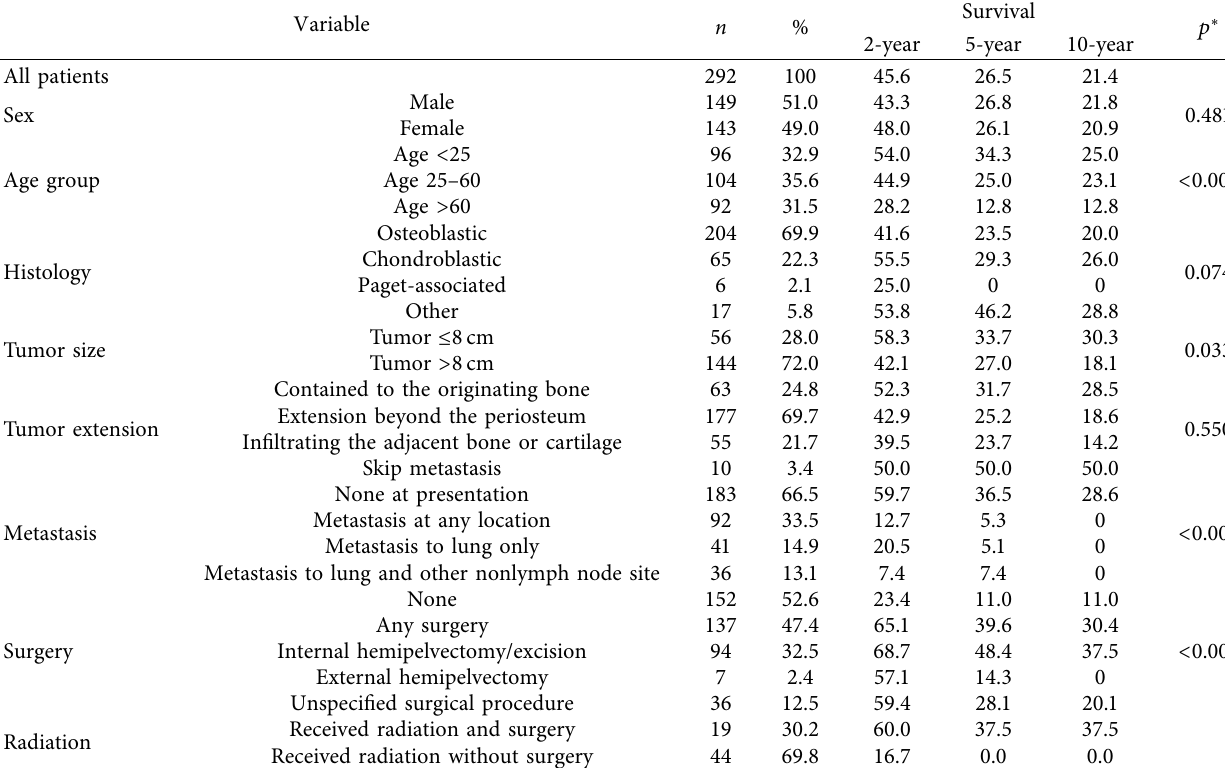
Figure 1: Age group histogram for osteosarcoma of the pelvis. A bimodal distribution is observed in adolescents and older adults. Table 1: Demographics and tumor characteristics for patients with primary osteosarcoma of the pelvis within the SEER database, 2004–2015, with 2-, 5-, and 10-year